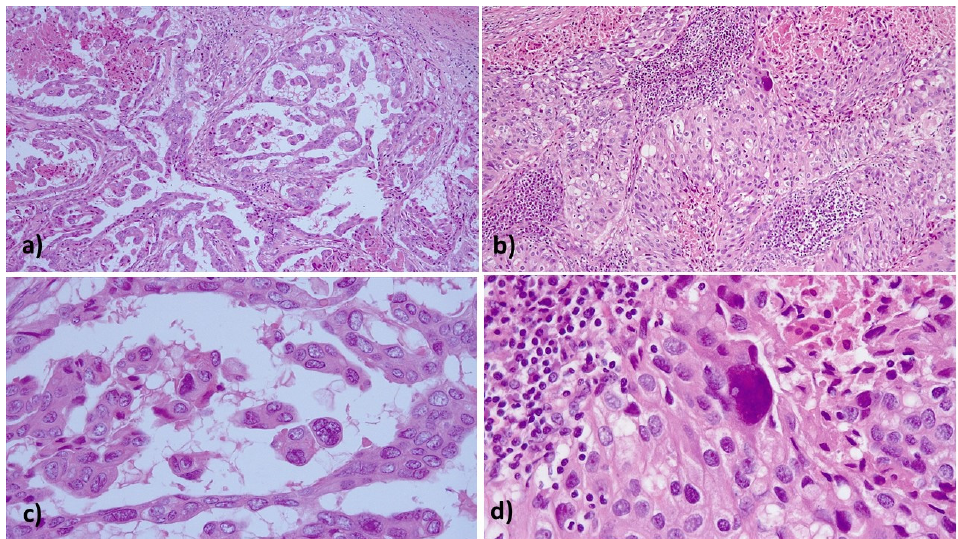
Figure 1 . Histopathological findings: ( a ) papillary architecture of Bartholin gland carcinoma with necrosis (HE 200×); ( b ) infiltrating nest of poorly differentiated adenocarcinoma with solid and glandular pattern (HE 200×); ( c , d ) moderate to severe nuclear atypia with eosinophilic cytoplasm in the papillary and solid architecture (HE 400×).